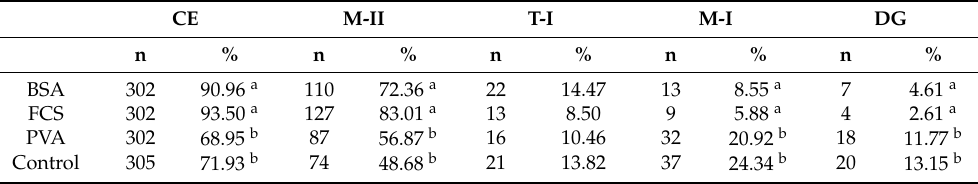
Table 2. Meiosis status of bovine oocytes matured in media supplemented with BSA, FCS, and PVA.